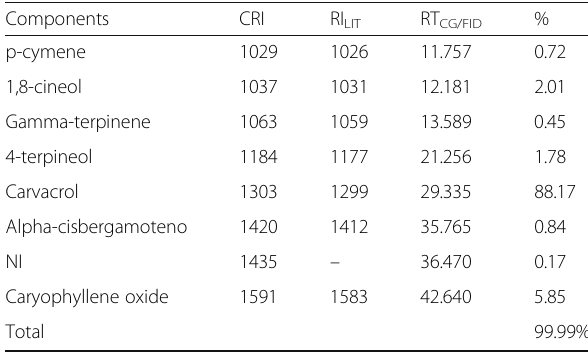
Table 2 Chemical characterization of the essential oil extracted from leaves of Plectranthus amboinicus